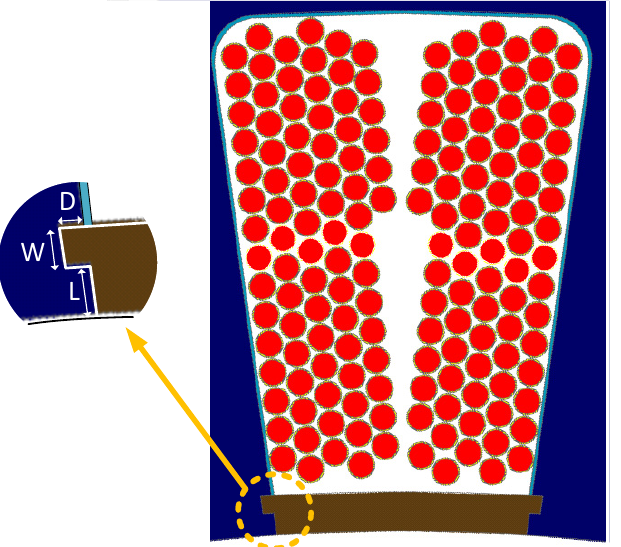
Figure 11. Coil retention with grooves and slot wedge, and the geometry parameters of the slot wedge.